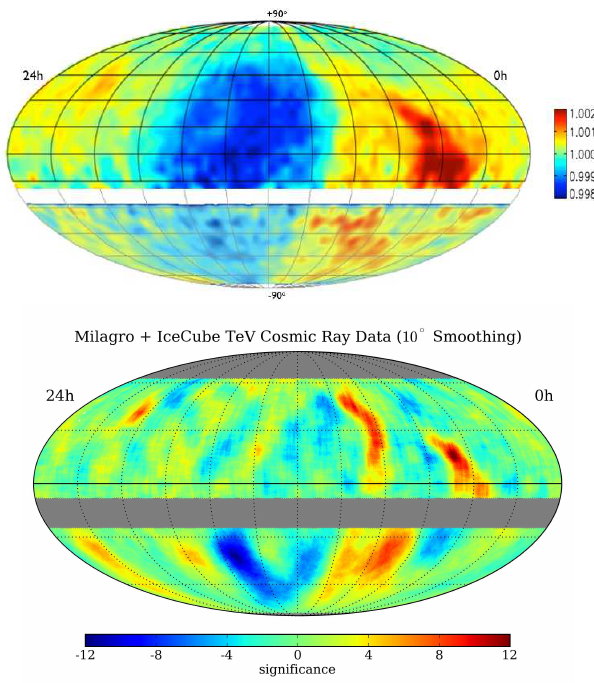
Fig. 1. Top panel: map in equatorial coordinates of the relative in- Fig. 1. Top panel : Map in equatorial coordinates of the relative in- tensity of the cosmic ray arrival distribution as observed by the Tibet tensity of the cosmic ray arrival distribution as observed by the Tibet AS γ at about 5TeV in the Northern Hemisphere (from Amenomori AS γ at about 5 TeV in the northern hemisphere (from Amenomori et al., 2011a), and by the IceCube Observatory at a median energy et al. (2011a)) and by the IceCube Observatory at a median energy of 20TeV in the Southern Hemisphere (from Abbasi et al., 2010). of 20 TeV in the southern hemisphere (from Abbasi et al. (2010)). Bottom panel: map in equatorial coordinates of the statistical sig- Bottom panel : Map in equatorial coordinates of the statistical sig- nificance of the cosmic ray arrival direction distribution as observed nificance of the cosmic ray arrival direction distribution as observed by Milagro at about 1TeV in the Northern Hemisphere (from Abdo by Milagro at about 1 TeV in the northern hemisphere (from Abdo et al., 2008), and by the IceCube Observatory at a median energy et al. (2008)) and by the IceCube Observatory at a median energy of of 20TeV in the Southern Hemisphere (from Abbasi et al., 2011). 20 TeV in the southern hemisphere (from Abbasi et al. (2011b)). In In this map features with angular extension larger than 30–60 ◦ are this map features with angular extension larger than 30 ◦ − 60 ◦ are filtered filtered out.